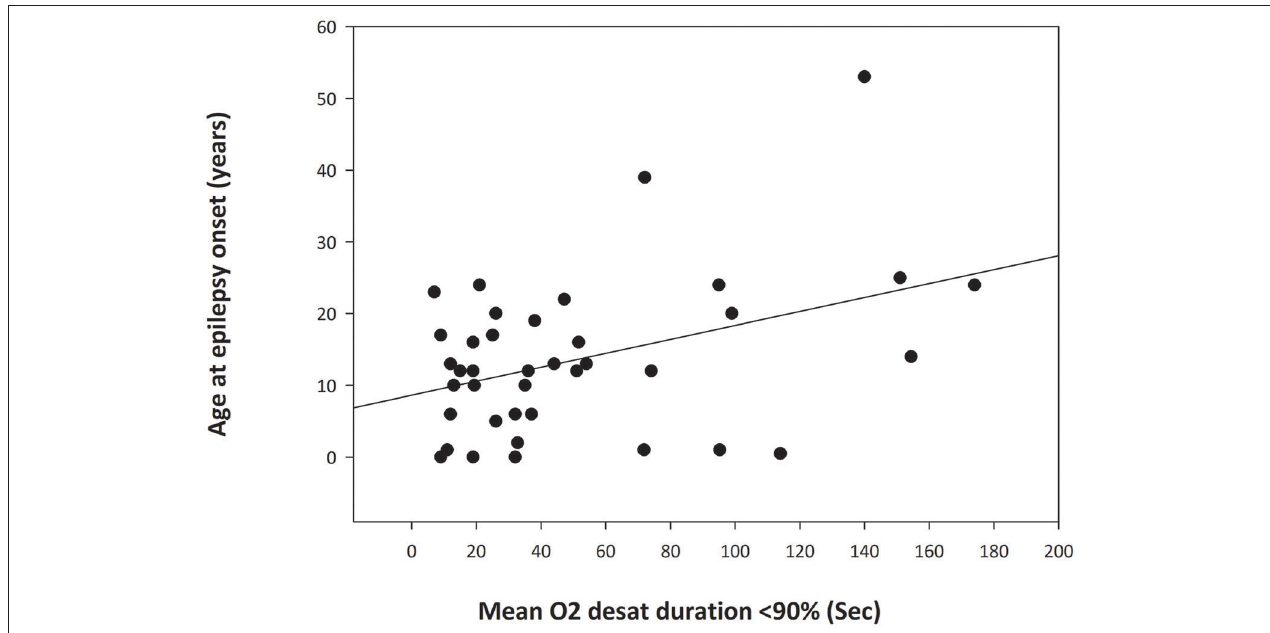
FIGURE 1 | Simple Linear Regression analysis graph demonstrating relationship between the age at epilepsy onset and duration of oxygen desaturation of < 90% in focal seizures without secondary generalization ( p = 0.012). The abscissa indicates the mean duration of postictal oxygen desaturation below 90% in seconds. The ordinate is the patient age at onset of epilepsy in years. The filled circles are data points for each patient. The solid line through the data points is the regression line.